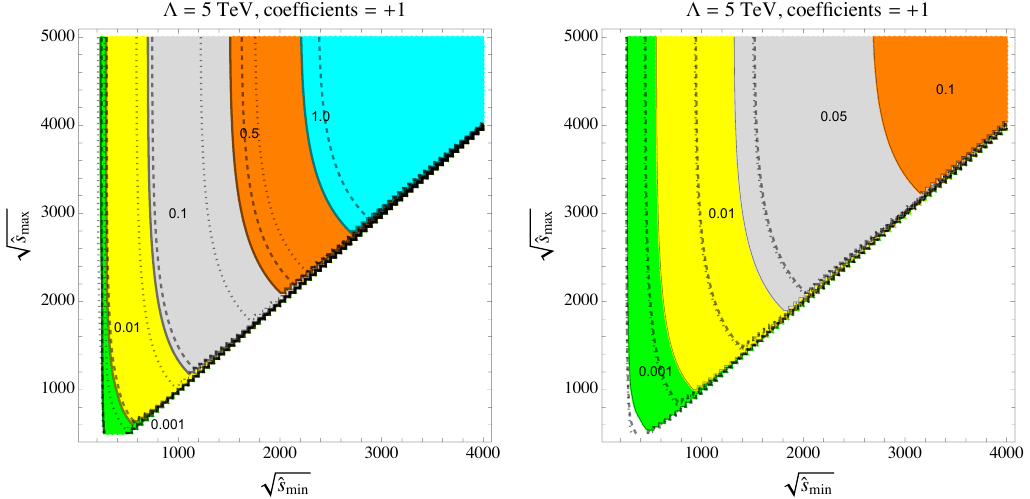
Figure 2 . In the left panel, we show the absolute value of the ratio of the cross section in the full, O (1 / Λ 4 ) calculation to the linear O (1 / Λ 2 ) calculation as a function of the minimum center of √ √ mass energy ˆ s and the maximum ˆ s : | ( σ ( pp → ‘ + ν ) ) /σ ( pp → − σ ( pp → ‘ + ν ) min max O ( x 2 ) O ( x ) ‘ + ν ) | . All Wilson coefficients are taken to be positive and equal to one, and the new physics O ( x ) scale Λ = 5 TeV. In the right plot we show the ratio (absolute value) of the O (1 / Λ 4 ) calculation √ √ to the cross section including only dimension six operators as a function of ˆ s and ˆ s : min max ) /σ ( pp → ‘ + ν ) | ( σ ( pp → ‘ + ν ) − σ ( pp → ‘ + ν ) | . The lower right O ( x 2 ) O ( x 2 ) ,nodim − 8 O ( x 2 ) ,no dim − 8 √ √ portion is unphysical as ˆ s ˆ s , and the step-like structure of the edge of this boundary is min > max a numerical artifact. The dotted (dashed) black lines represent the contours where we have chosen the signs of C s, 3 , (8) and C t, 3 , (8) to maximize (minimize) eq. (3.2) instead of taking all dimension LQ LQ eight coefficients to be +1